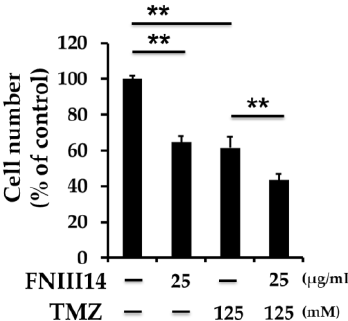
Figure 5. Peptide FNIII14 augments a TMZ-induced antitumor effect. Mouse glioma GL261 cells were treated with the indicated concentrations of peptide FNIII14 in the presence or absence of TMZ for 3 days. Cells were subjected to WST-8 assay. Each point represents the mean ± SD, ** p < 0.01.